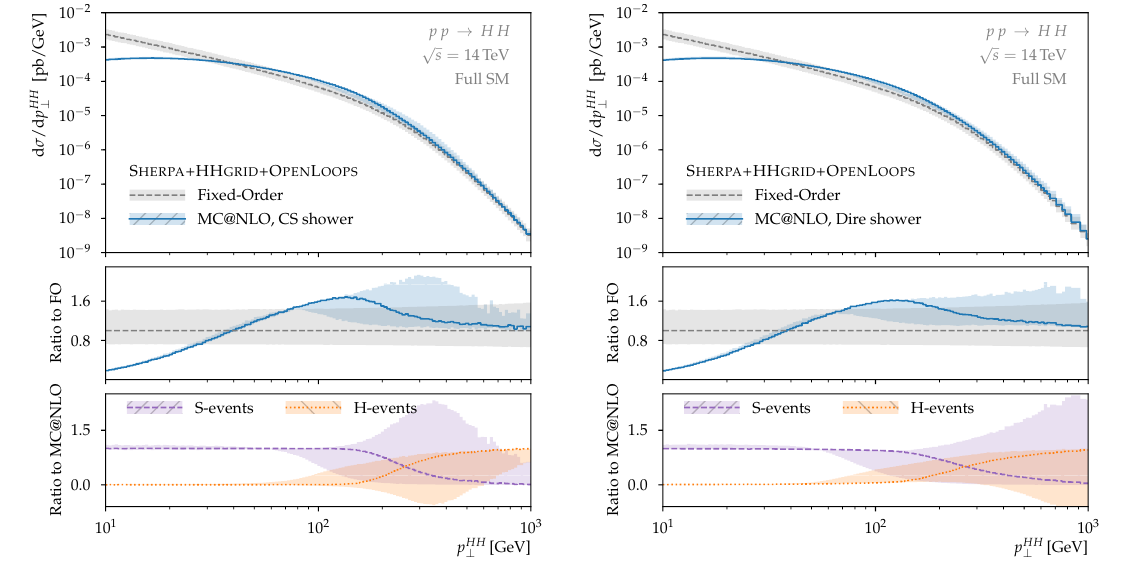
Figure 5 . Parton shower NLO matching e(cid:11)ects on the p HH spectrum in a full SM calculation. The ? left panel shows results obtained with the CS shower, while the results on the right were generated with the Dire shower. The uncertainty band around the (cid:12)xed-order result is obtained through variations of (cid:22) F and (cid:22) R . Uncertainties on the MC@NLO predictions are obtained by varying (cid:22) PS .